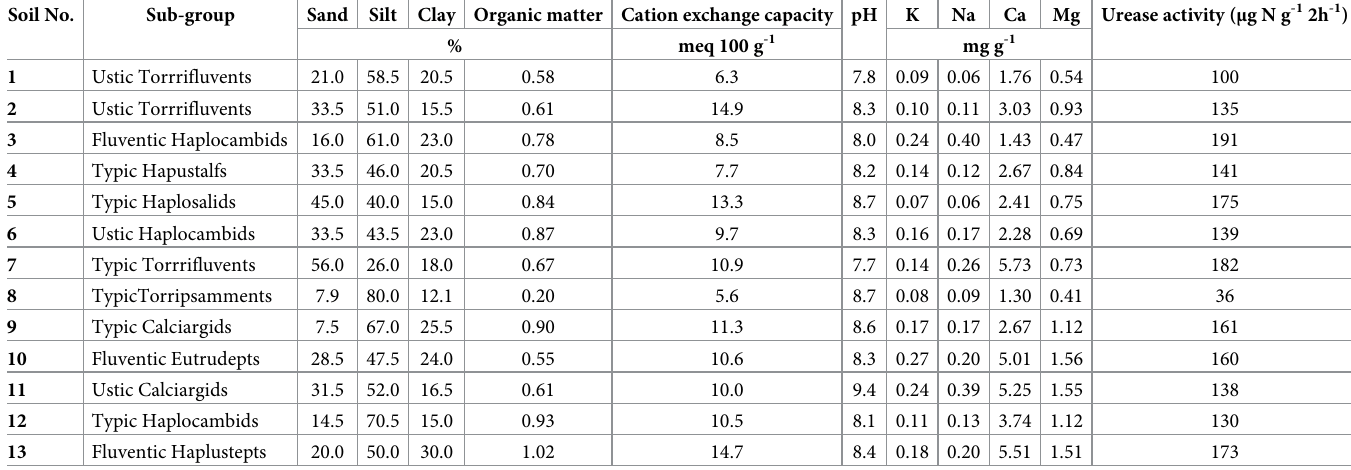
Table 2. Characteristics of thirteen soils used in urease inhibition assay using plant extracts. Soil